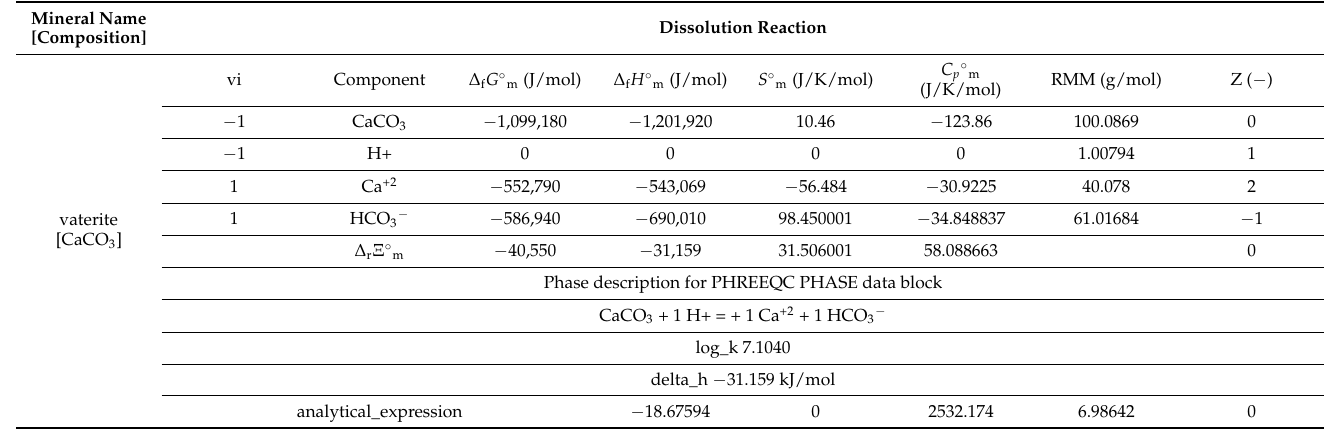
Table 2. Thermodynamic data to derive vaterite phases taken from [25].